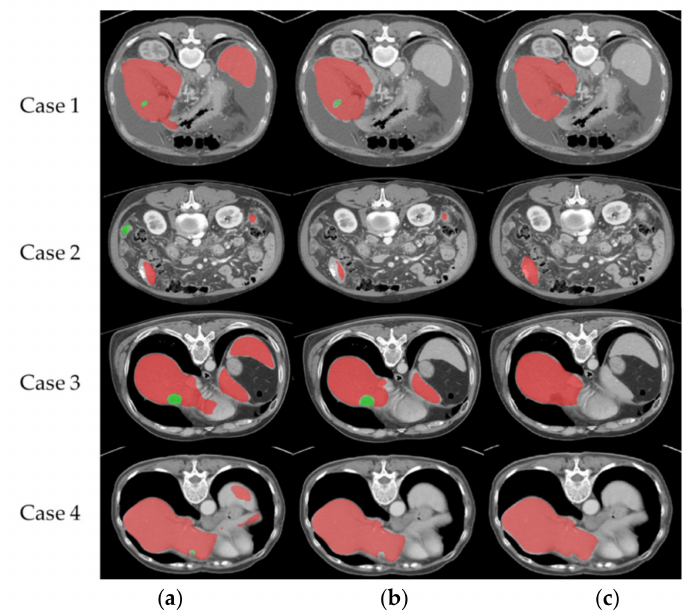
Figure 9. Comparative difference in segmentation of each case output: row ( a ) is the recognition output after training with the LiTS database, row ( b ) is the recognition output after training with 30 hospital data, and row ( c ) is the ground truth. (red is liver part, green is lesion